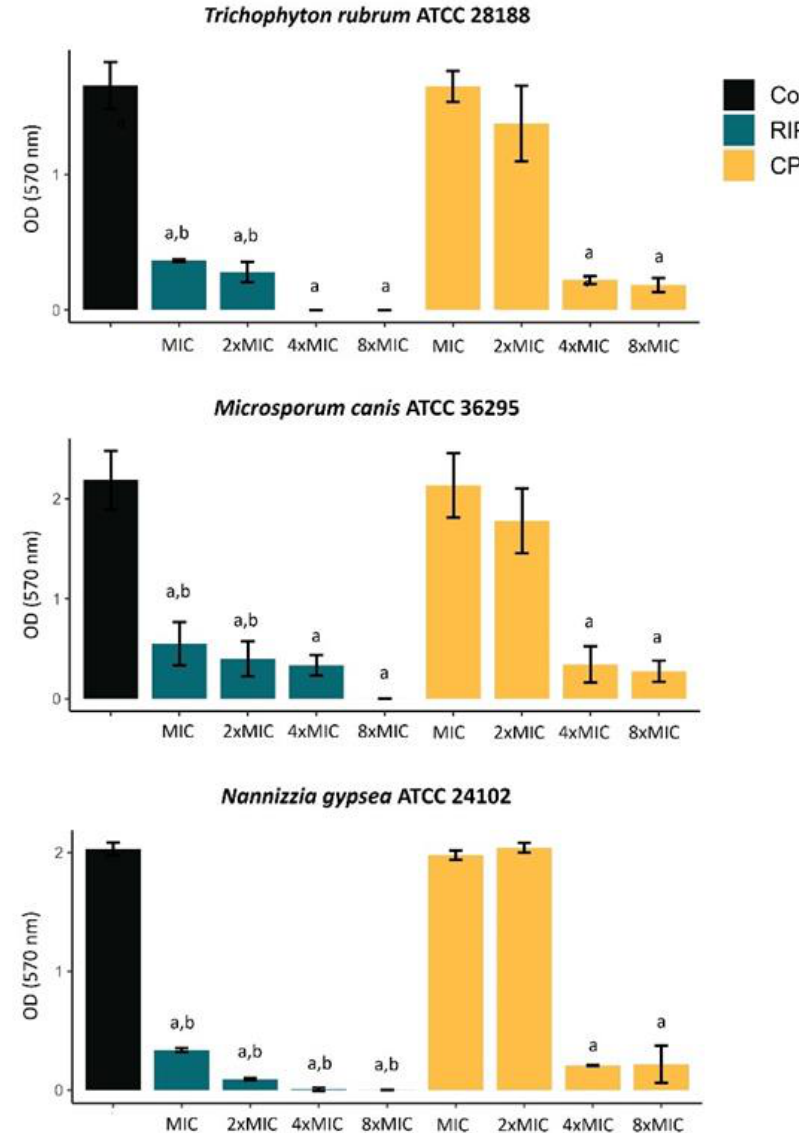
Figure 2. Effect of RIP3 on the biofilm biomass of dermatophytes expressed as absorbance of the crystal violet staining. The results are the means ± SD from three independent experiments. Signifi- cant difference ( p < 0.05) when compared to drug-free growth control (a) and to CPX at the respec- tive MIC value (b). OD, optical density; MIC, minimal inhibitory concentration; RIP3, riparin III; CPX, ciclopirox.